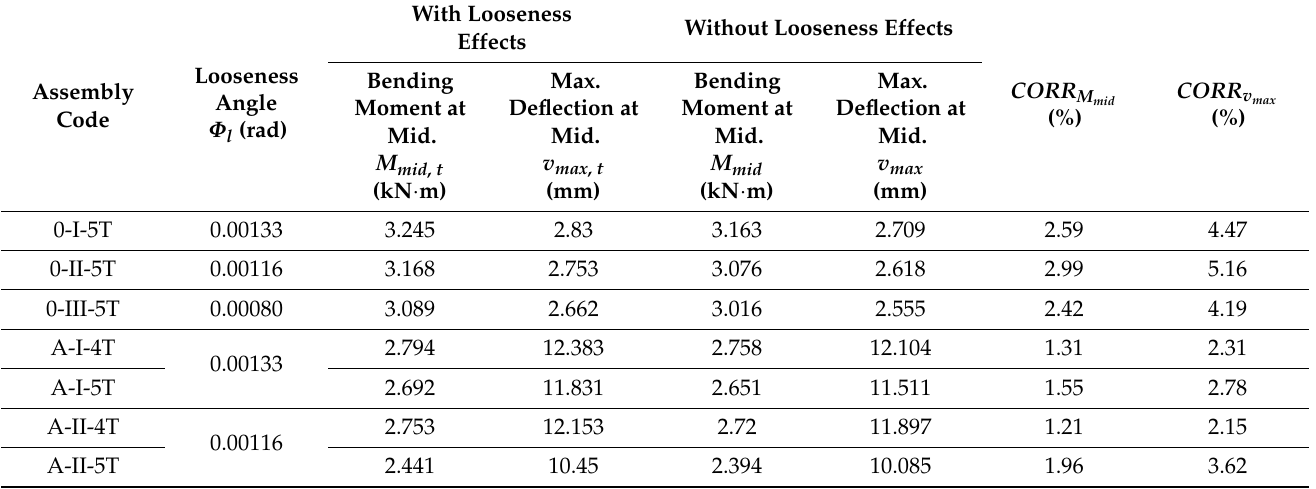
Table 4. The looseness effects on the bending moment and maximum deflection at the middle of the beam for the upright-connector-beam assemblies